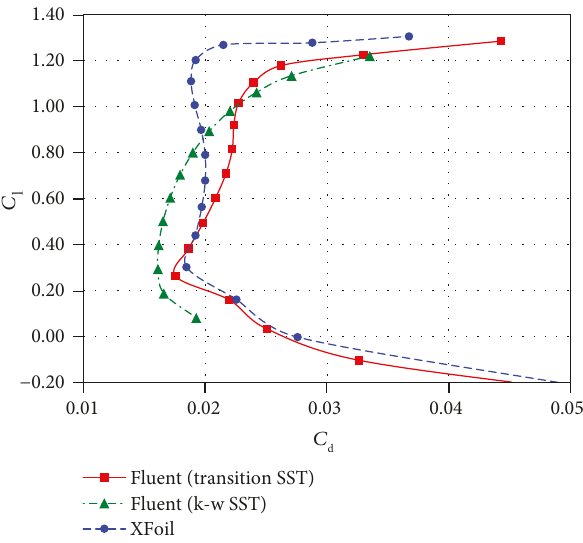
Figure 3: Comparison of drag polar calculated by three